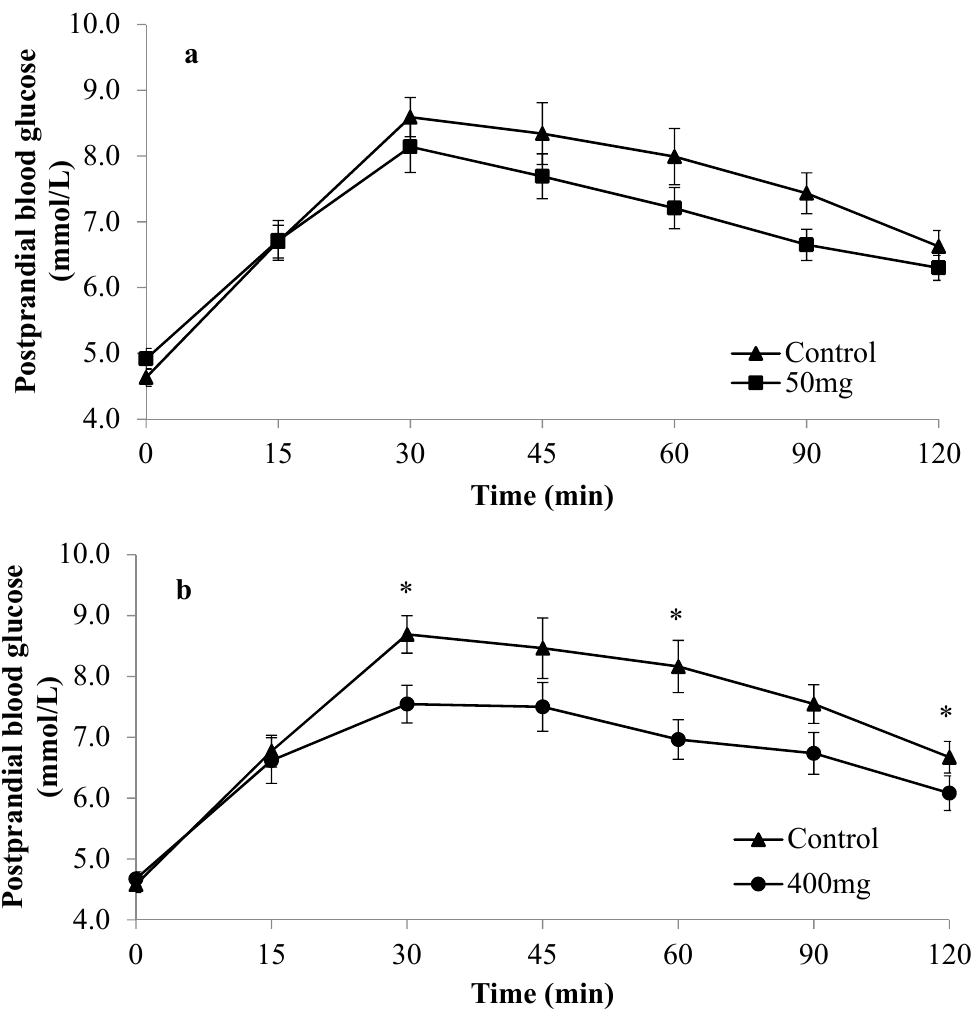
Figure 1. Mean postprandial glucose ( ± SEM) of participants with a monophasic curve shape during the control and treatment visits with ( a ) 50 and ( b ) 400 mg of Enzogenol ® . * p < 0.05 for 400 mg Enzogenol ® compared to control.